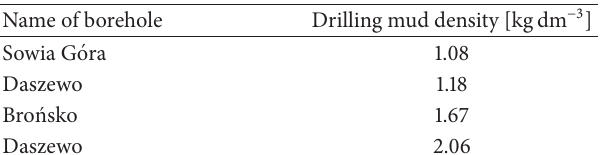
Table 2: The densities of drilling muds originating from different boreholes.